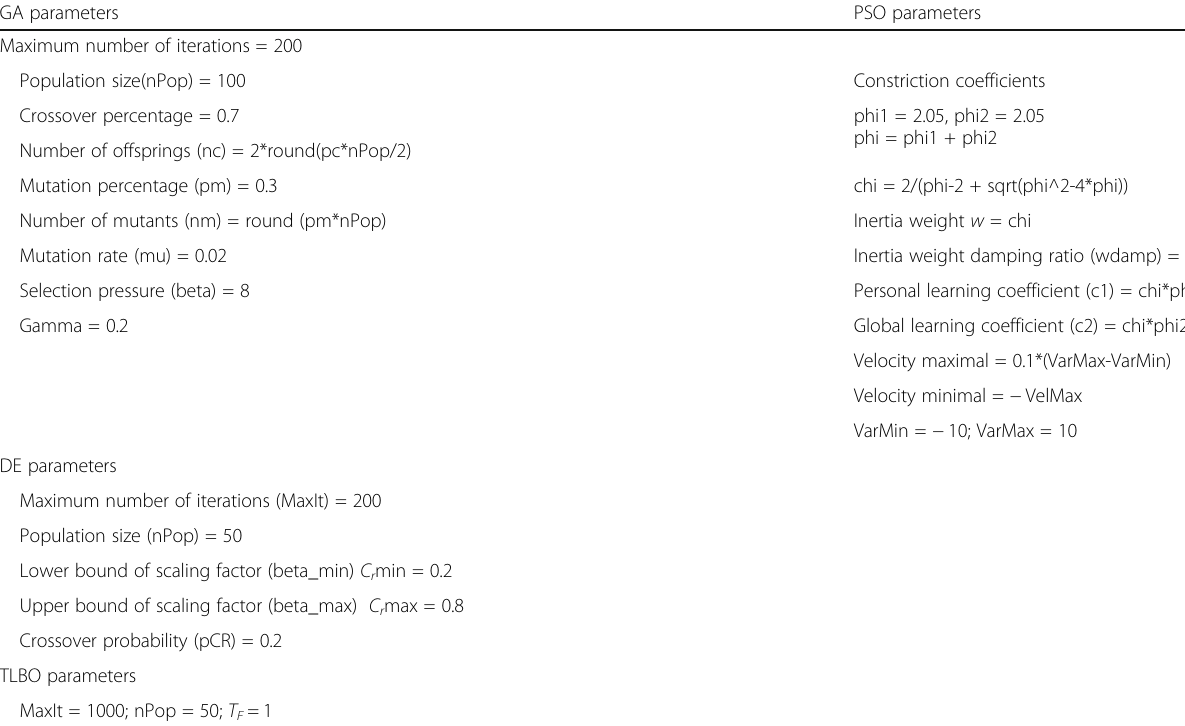
Table 1 The best parameters setting given the best cost solution for all proposed